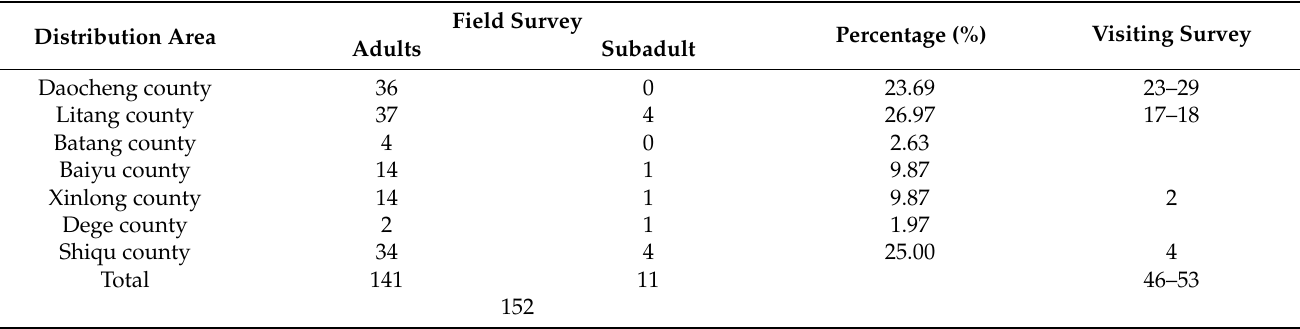
Table 1. The numbers and distribution of black-necked cranes in the Shaluli